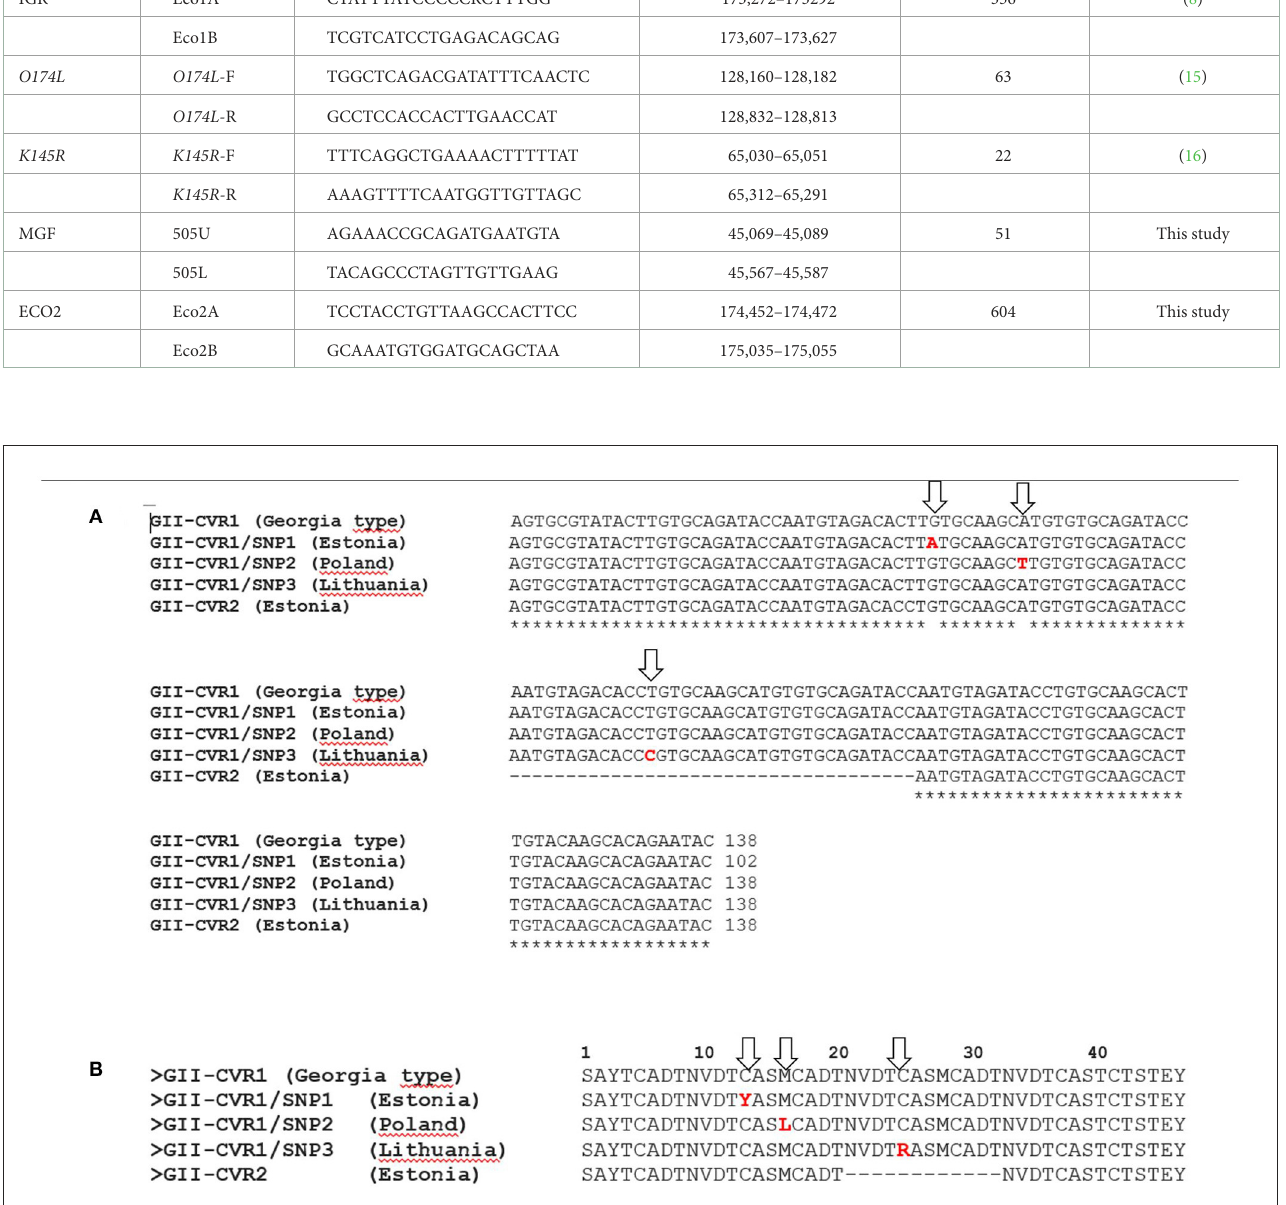
had not been previously identified in Europe or Asia, as demonstrated by comparison with 495 genotype II-ASFV homologous sequences available in the